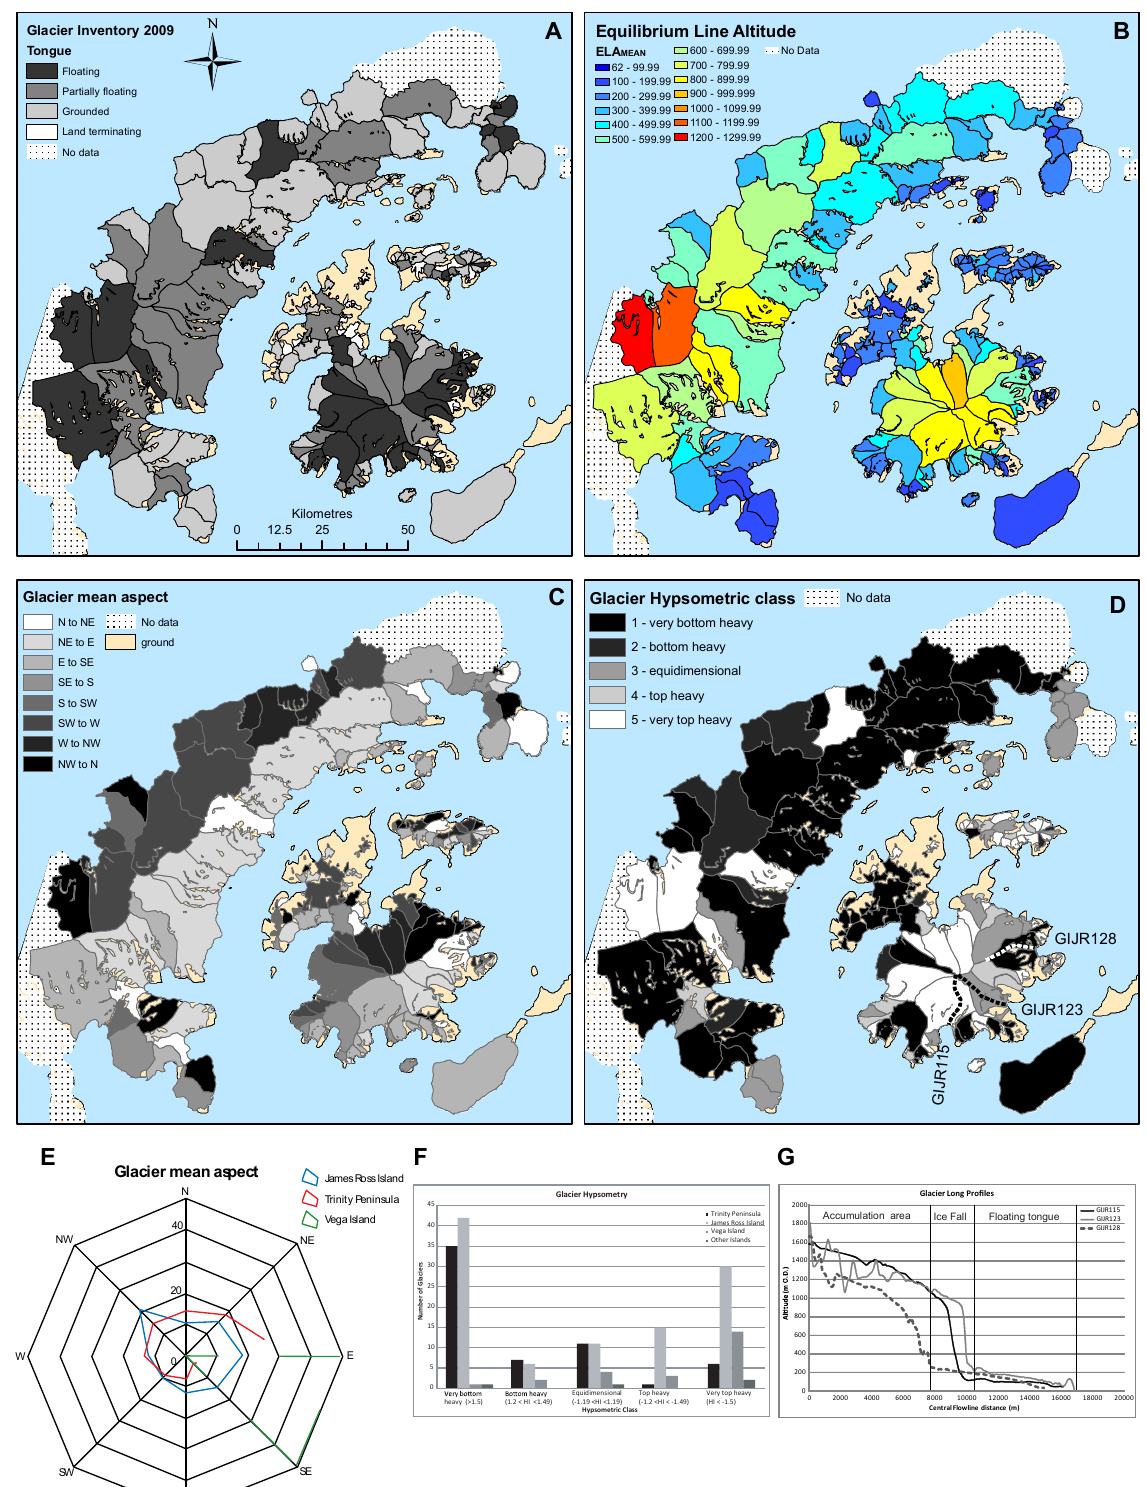
Fig. 3. (A) Floating, partially floating and grounded tongues at glacier termini in 2009. (B) Mean ELA in 2006. (C) Mean aspect in 2006. (D) Distribution of hypsometric classes. (E) Percentages of glaciers in each cardinal direction. (F) Frequency distribution of different hypsometric indices in different regions. (G) Long profiles of three tidewater glaciers on James Ross Island in